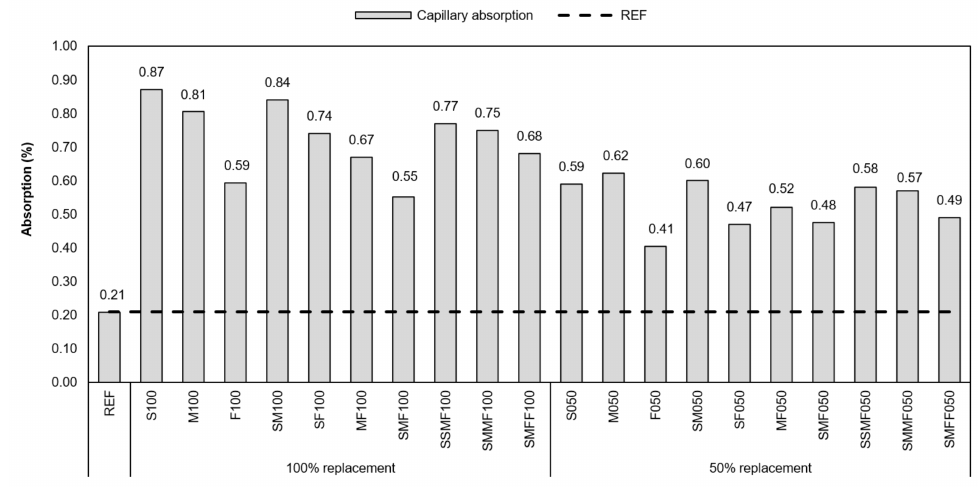
Figure A10. Capillary